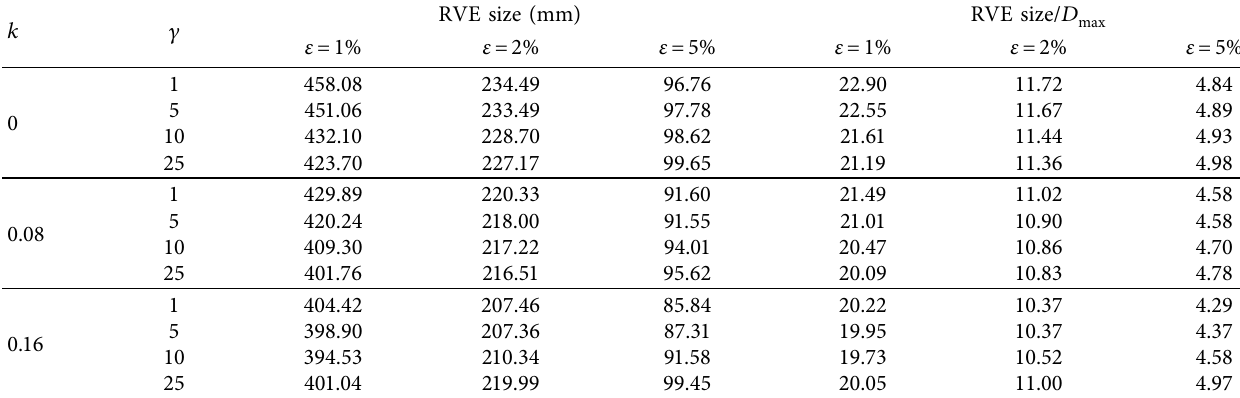
Table 2: RVE size estimation under diferent expectation errors.